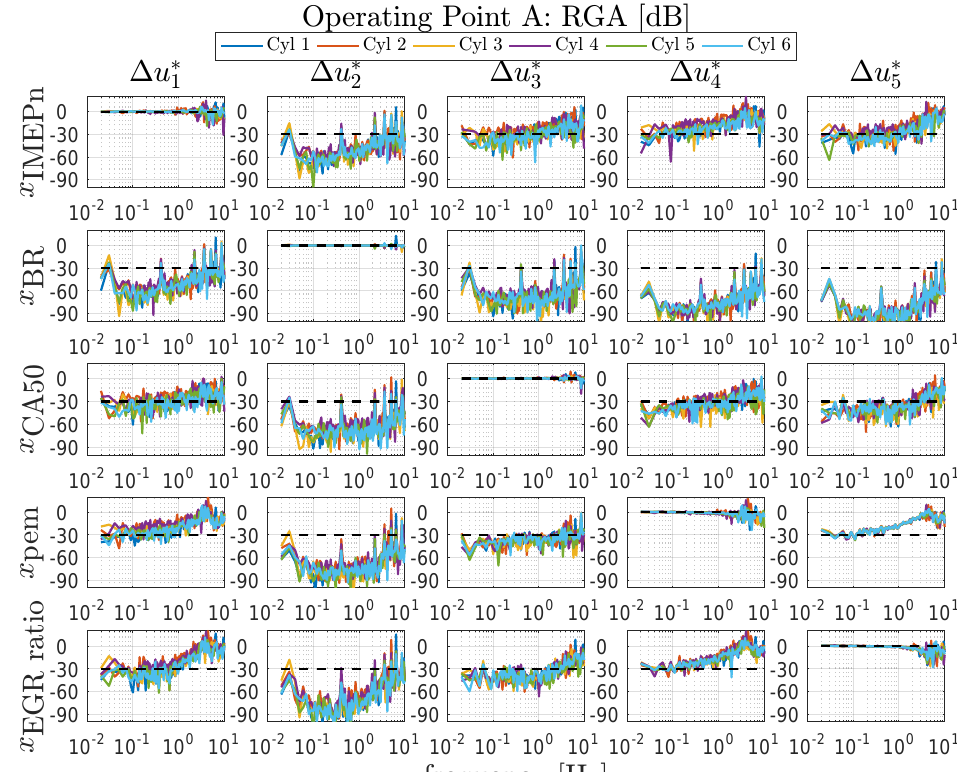
Figure 5. Results of the interaction analysis for decoupled plant ¯ G q ( j ω ) in operating point